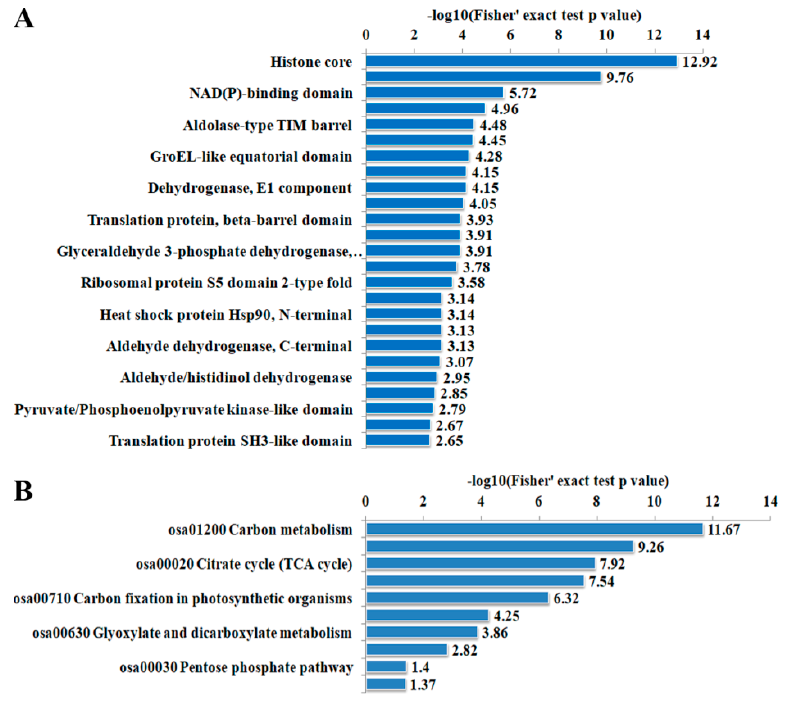
Figure 5. Protein domain enrichment analysis ( A ) and KEGG pathway enrichment analysis ( B ) proteins identified acetylproteins in this study.